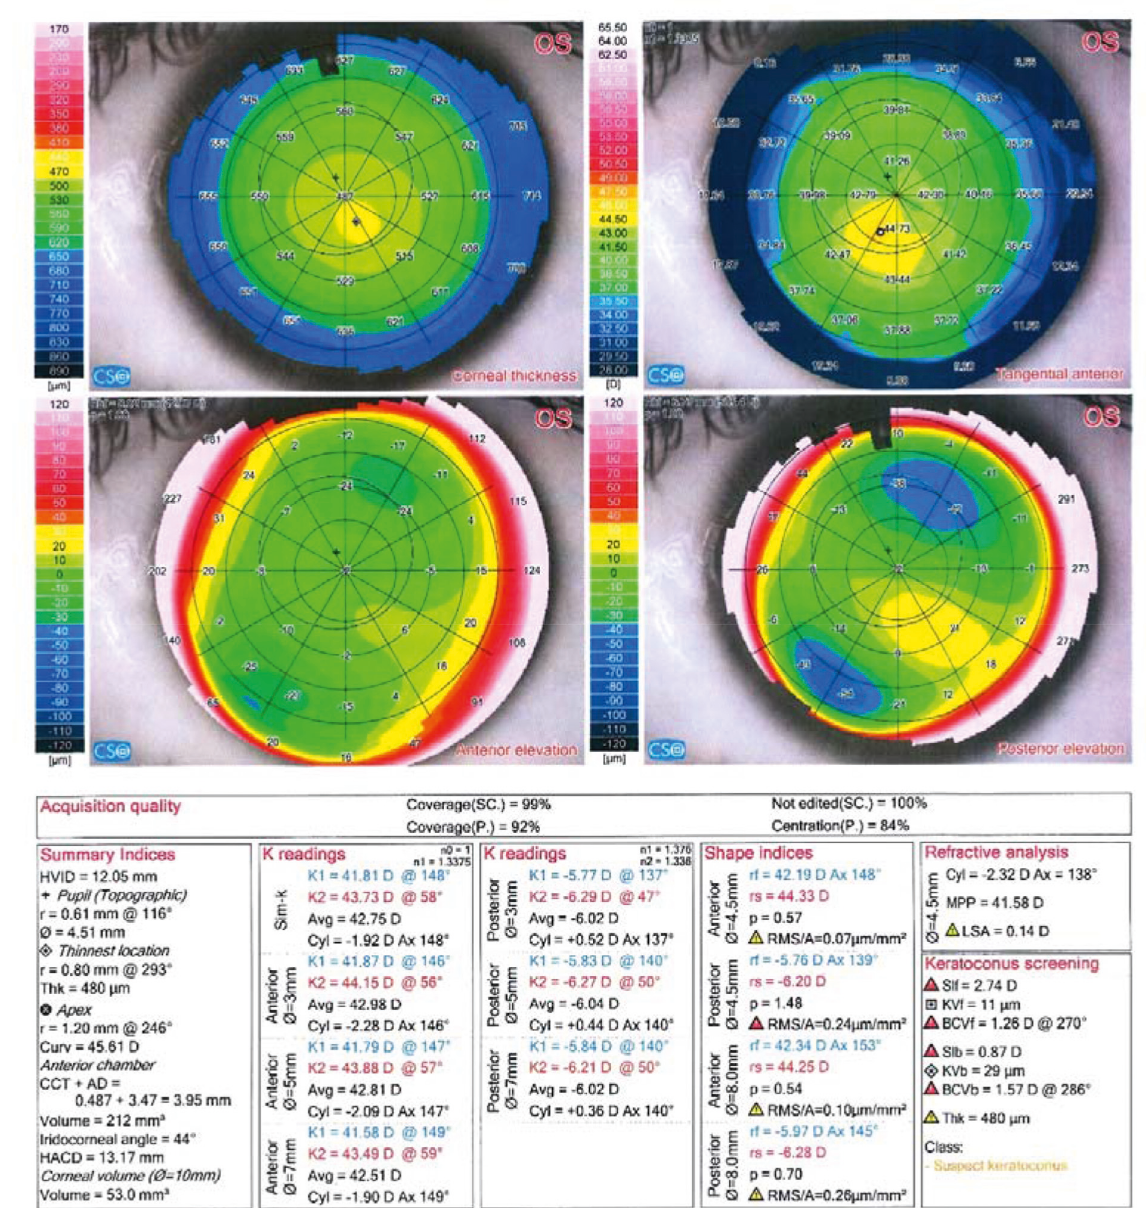
Figure 2: Sirius (v) 2.6 quad map of a case with a suspect